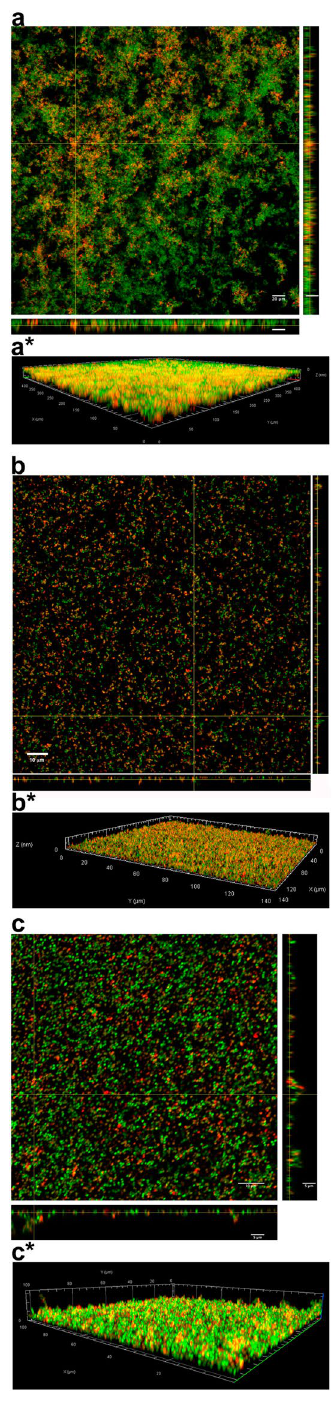
Figure 2. LL-37 binding to bacterial biofilm. Three S . aureus isolates, derived from three patients with AD, were grown on Cellview TM cell culture dishes for 6 days to form mature biofilms. After washing away the planktonic cells, the bacterial cells of the biofilm (green) were stained with SYTO ® 9 green fluorescent stain and then incubated with TAMRA-labeled LL-37 (red), co-existence of bacterial cells and the TAMRA-labeled LL-37 peptide is represented by yellow color. CLSM orthogonal images of Z-stacks show a plane view (square) looking down the biofilm and side views through the biofilm (right and below). Magnification in ( a ) × 20, bar 20 μ m, in ( b ) × 63, bar 10 μ m and in ( c ) × 63, bars 10 μ m and 5 μ m. * 3D view of the corresponding